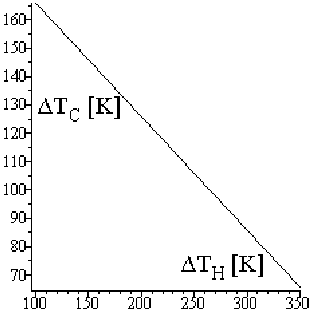
Figure 5. Δ T C dependence of Δ T H —case “b”.